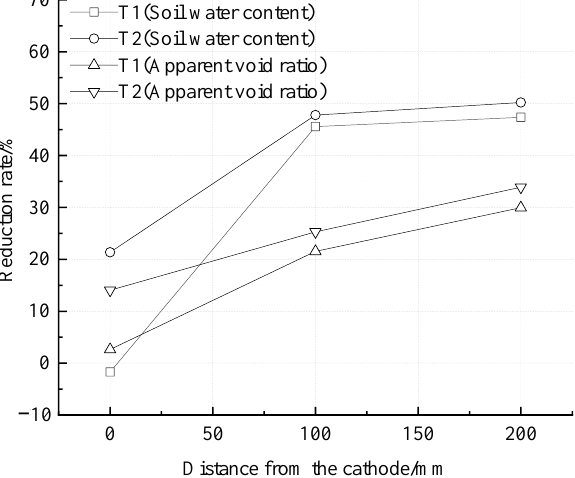
Figure 11. Reduction rates in soil water content and the apparent void ratio.